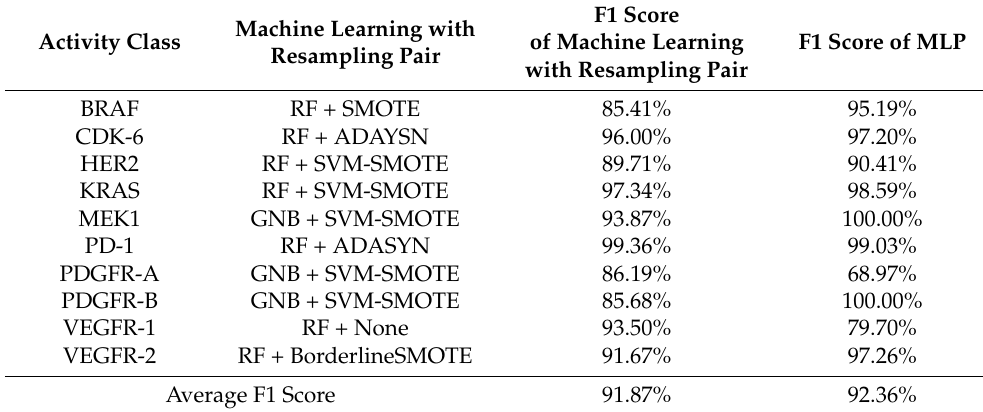
Table 5. Comparison between the F1 score of machine learning paired with resampling and the F1 score of